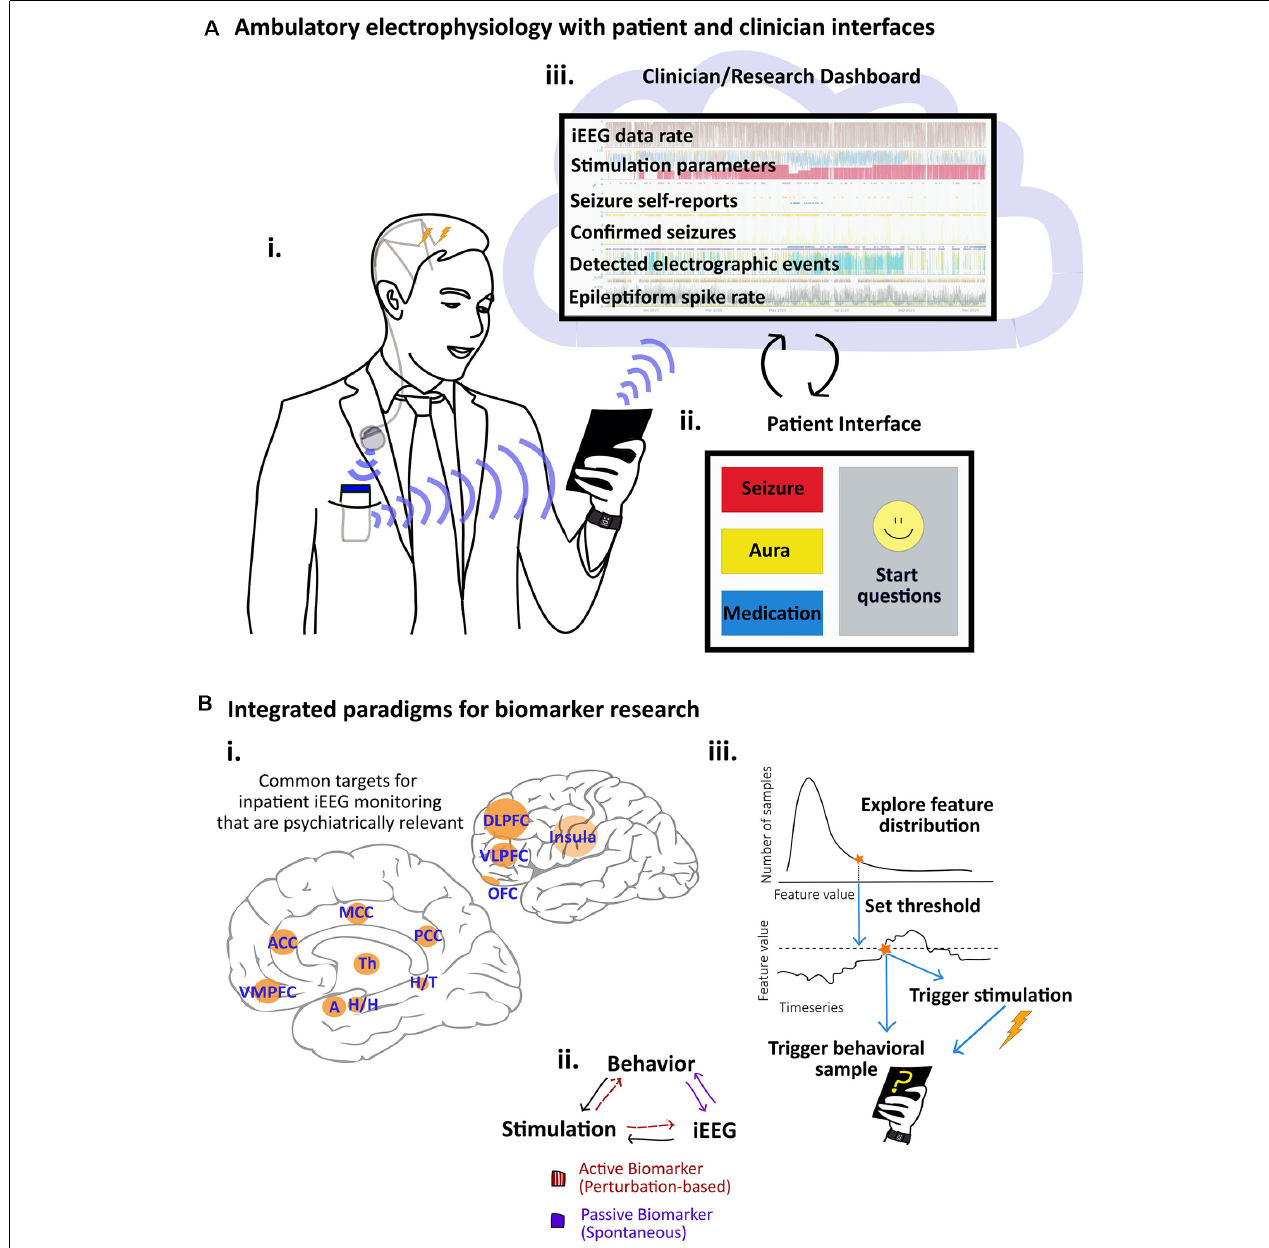
FIGURE 1 | Paradigms and systems for integrated electrophysiology and behavior research. (A) System for ambulatory electrophysiology with integrated patient and clinician interfaces. (i) Patient with implanted bilateral intracranial depth electrodes connected to subclavicular internal pulse generator (IPG) for deep brain stimulation (DBS) for drug-resistant focal epilepsy. Data from the IPG are transmitted to the pocket-sized relay device which then transmits the data via Bluetooth to a small tablet. The patient is shown with a wearable “smartwatch” device to highlight multimodal data options. (ii) The patient interface at the tablet is customized to enable the patient to log seizures, auras, and medications, participate in cognitive tasks and ecological momentary assessments (EMAs), and to check system battery levels and data streaming. (iii) Data reach the clinical cloud where device status, electrophysiological signals, and patient notes are combined on a clinician dashboard. Custom algorithms run on and off the devices and trends are used to guide remote adjustments of DBS parameters. (B) Approaches to biomarker identification. (i) The medial and lateral views of the brain show regions implicated in psychiatric pathology that are frequently targeted for Intracranial electroencephalographic (iEEG) recording in patients with epilepsy undergoing invasive monitoring: dorsolateral prefrontal cortex (DLPFC), insula, ventrolateral prefrontal cortex (VLPFC), ventromedial prefrontal cortex (VMPFC), amygdala (A), hippocampal head (H/G) and tail (H/T), thalamus (Th), orbitofrontal cortex (OFC), anterior cingulate cortex (ACC), middle cingulate cortex (MCC), posterior cingulate cortex (PCC). (ii) In platforms that integrate stimulation, iEEG, and behavioral assessments, putative biomarkers can be evaluated in active and perturbation-based or more passive and spontaneous approaches. (iii) In feature-driven behavioral sampling, we propose using integrated platforms to query behavioral states when ongoing electrographic activity has reached a particular threshold. As opposed to random behavioral queries, this approach may expedite the process of sampling a feature’s full distribution.